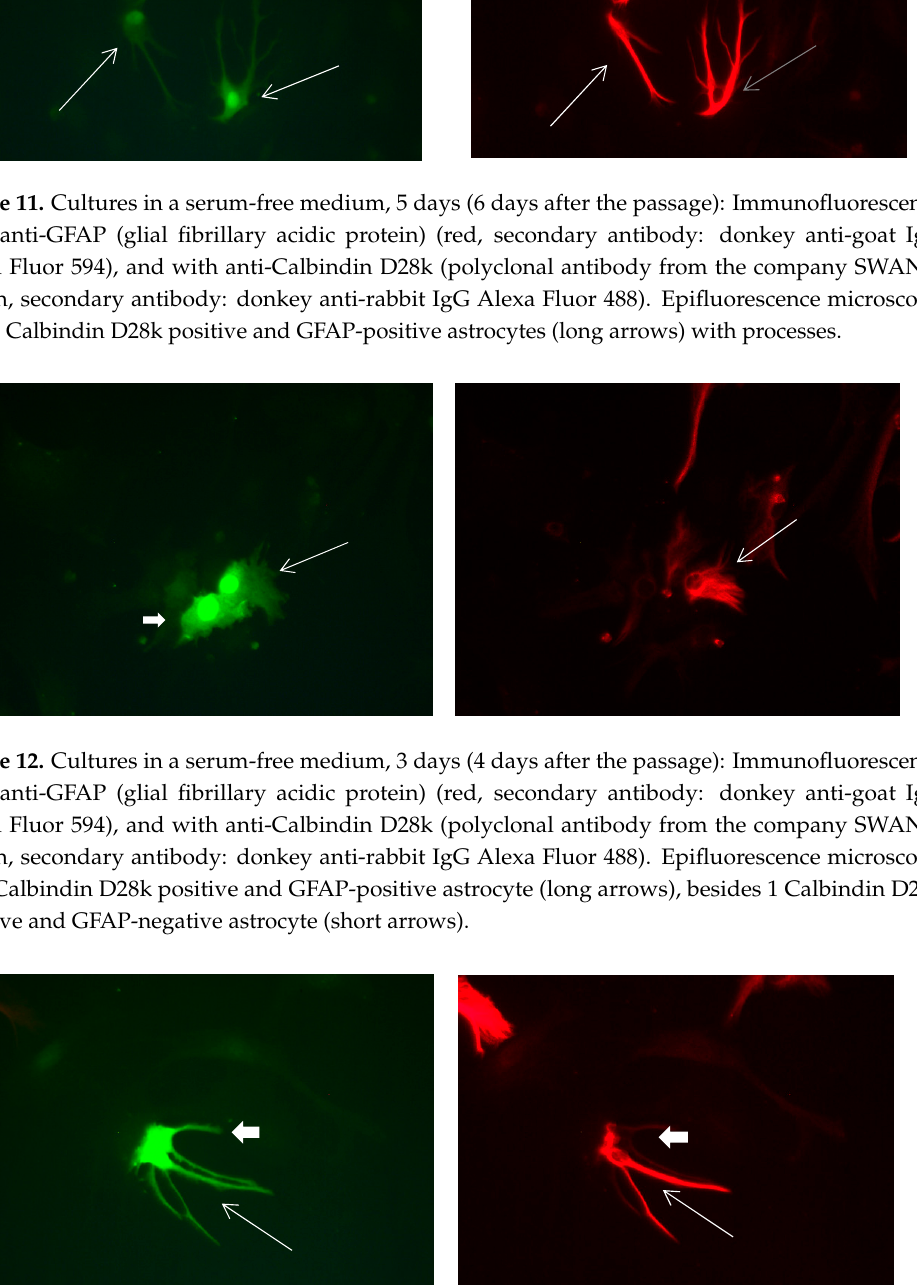
Figure 13. Cultures in a serum-free medium, 3 days (4 days after the passage): Immunofluorescence with anti-GFAP (glial fibrillary acidic protein) (red, secondary antibody: donkey anti-goat IgG Alexa Fluor 594), and with anti-Calbindin D28k (polyclonal antibody from the company SWANT) (green, secondary antibody: donkey anti-rabbit IgG Alexa Fluor 488). Epifluorescence microscopy. One Calbindin D28k positive and GFAP-positive astrocyte (long arrows), besides, 1 Calbindin D28k positive and GFAP-weak-positive astrocyte (short